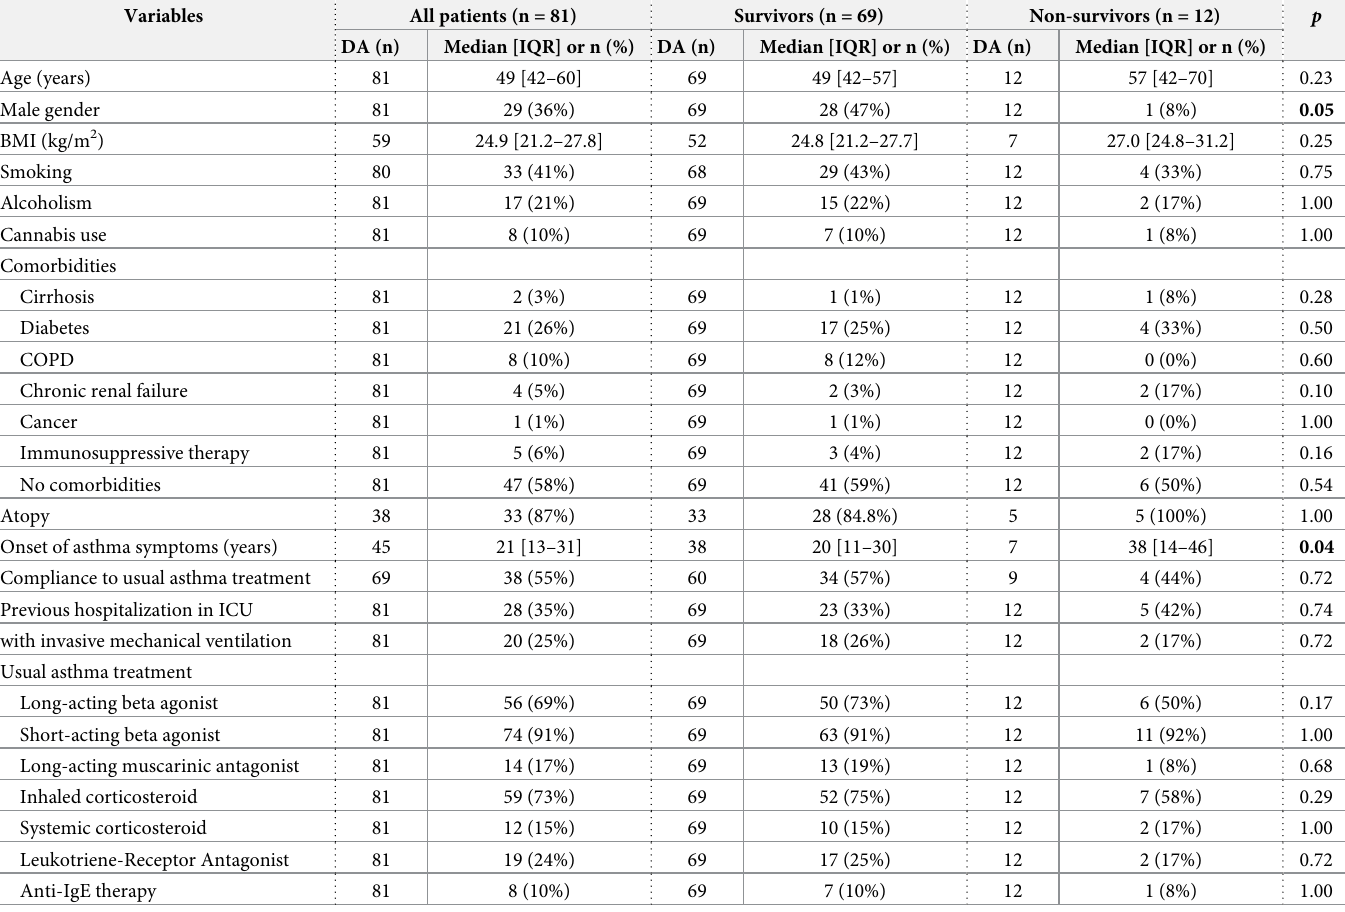
Table 1. Patients’ general characteristics and history of asthma according to in-hospital survival